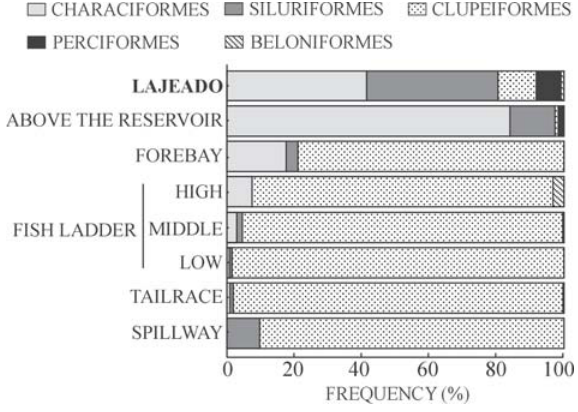
Fig. 4. Proportions of the different orders of fish in the larval samples taken near the Lajeado Dam, before (bold font) and after (regular font) dam closure and above the reservoir after its formation.